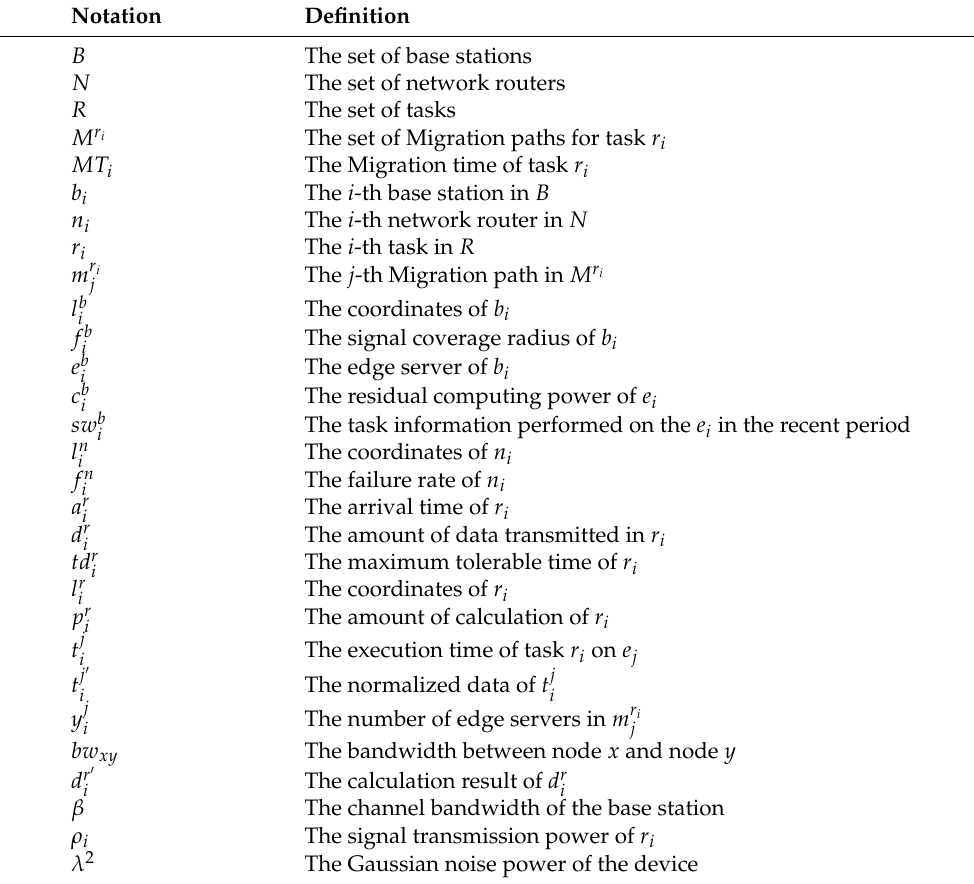
Table 1. Summary of